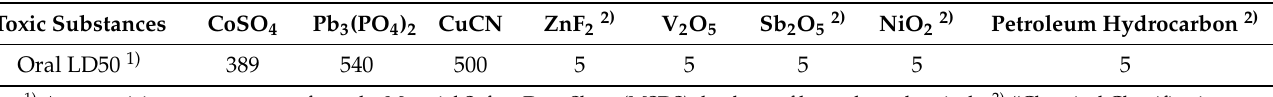
Table 5. Acute toxicity estimation parameters. Unit: